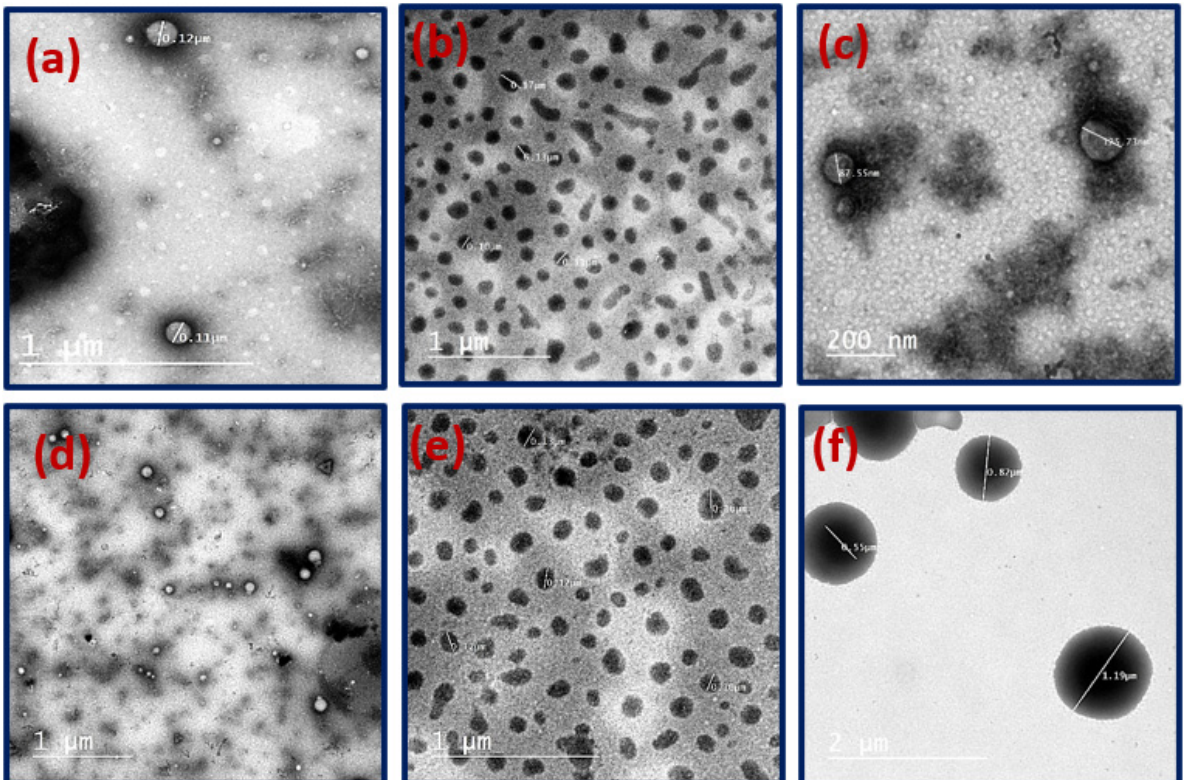
Figure 1. TEM micrographs of ( a ) plain pluronic nanomicelles (NMs), ( b , c ) PIP-loaded NMs (PIP-NMs) at different magnifications, ( d ) plain mixed pluronic nanomicelles (MNMs), and ( e , f ) MTX-loaded MNMs (MTX-MNMs) at different magnifications.